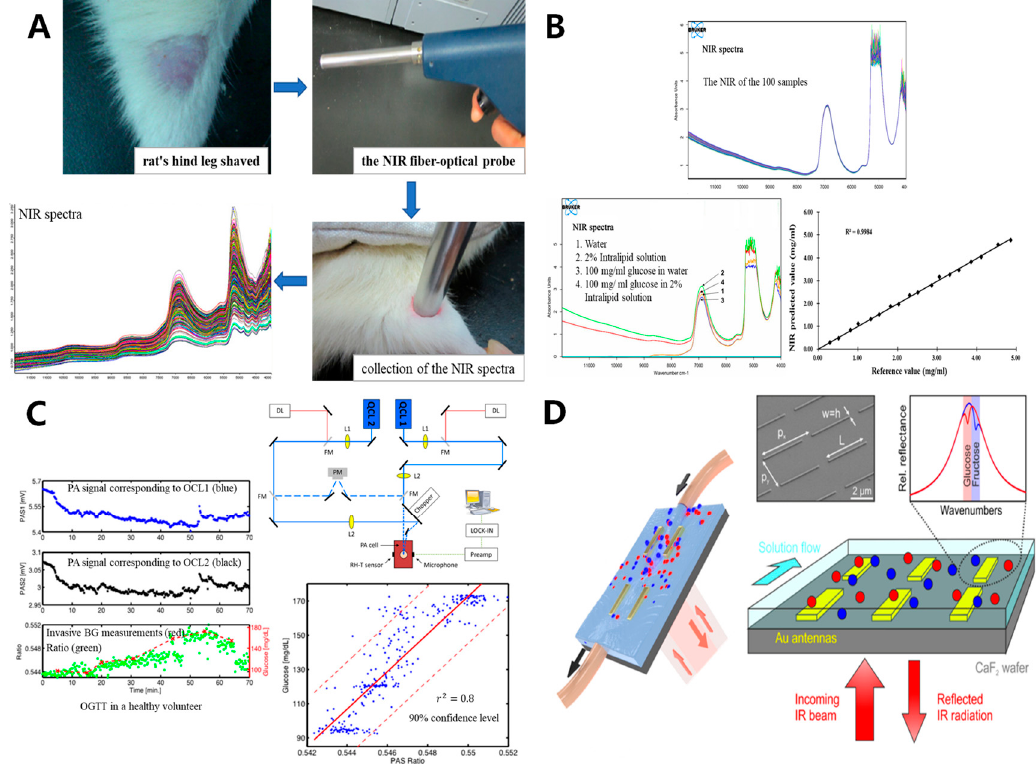
Figure 3. Near-infrared (NIR) and mid-infrared (MIR) spectroscopy methods. ( A ) Noninvasive and fast measurement of blood glucose in vivo by NIR spectroscopy. Adapted with permission [46].